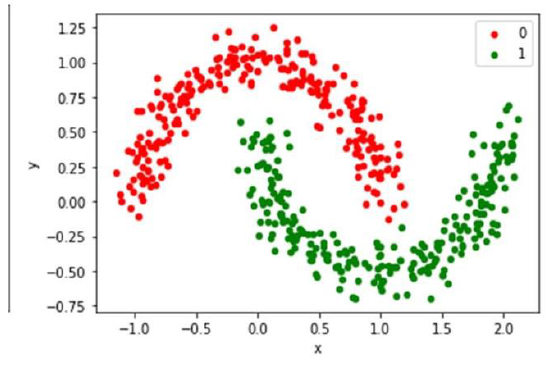
Figure 6. Dataset Sub-Type 2 (Moon)